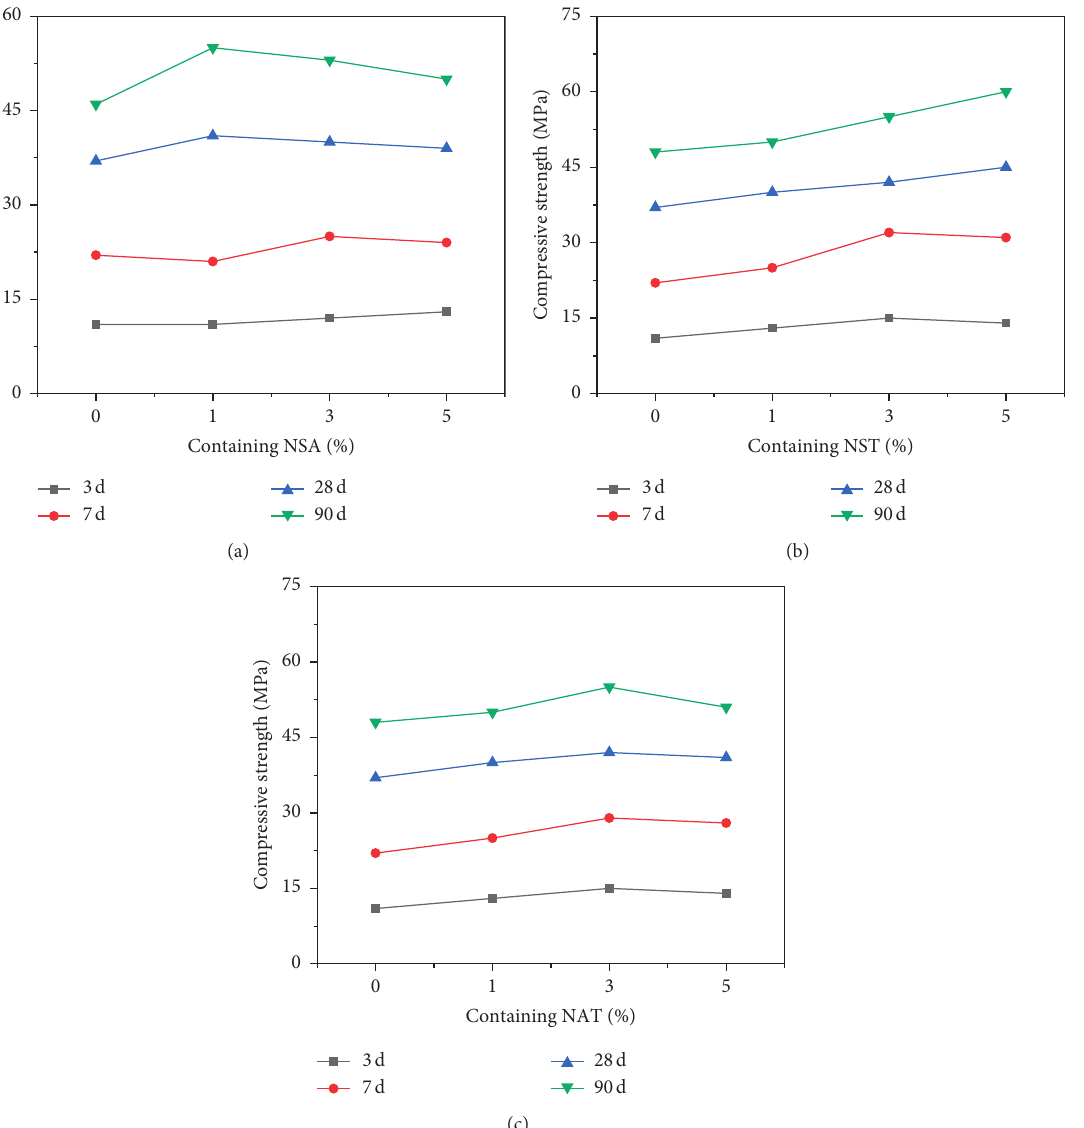
Figure 24: Variation of the compressive strengths of self-compacting mortars containing (a) NSA, (b) NST, and (c) NAT at different ages